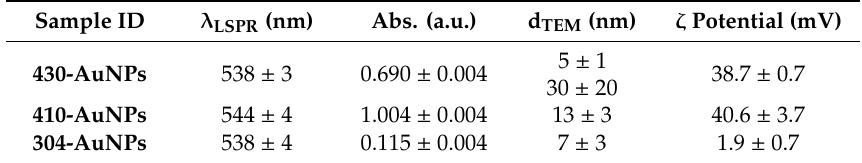
Table 4. LSPR position ( λ SPR ), absorbance (Abs.) at λ LSPR , AuNP mean diameters determined by TEM analysis (d TEM ), and zeta potential values ( ζ potential) obtained for 430-AuNPs, 410-AuNPs, and 304-AuNPs